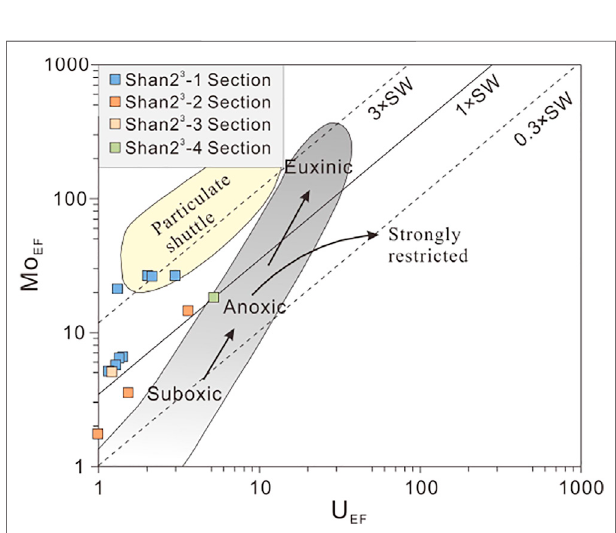
FIGURE 9 | Authigenic Mo-U covariation patterns for Shanxi Formation Shan 2 3 Submembershale.Thediagonallines represent multiples(0.3,1,and 3) of the Mo/U ratio of present-day seawater. Grey fi eld represents the “ unrestricted marine ” trend, characteristic of depositional systems with no limited trace metal renewal. Yellow fi eld represents the “ particulate shuttle ” trend, characteristic of environments in which intense redox cycling of metals occurs within the water column (Tribovillard et al.,